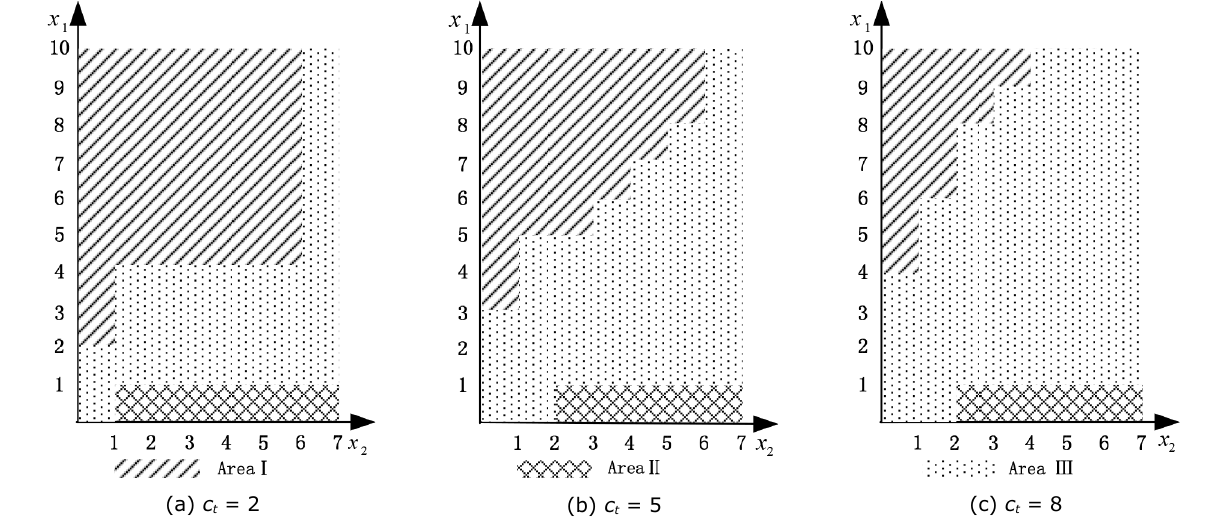
Figure 1. Region of preventive lateral